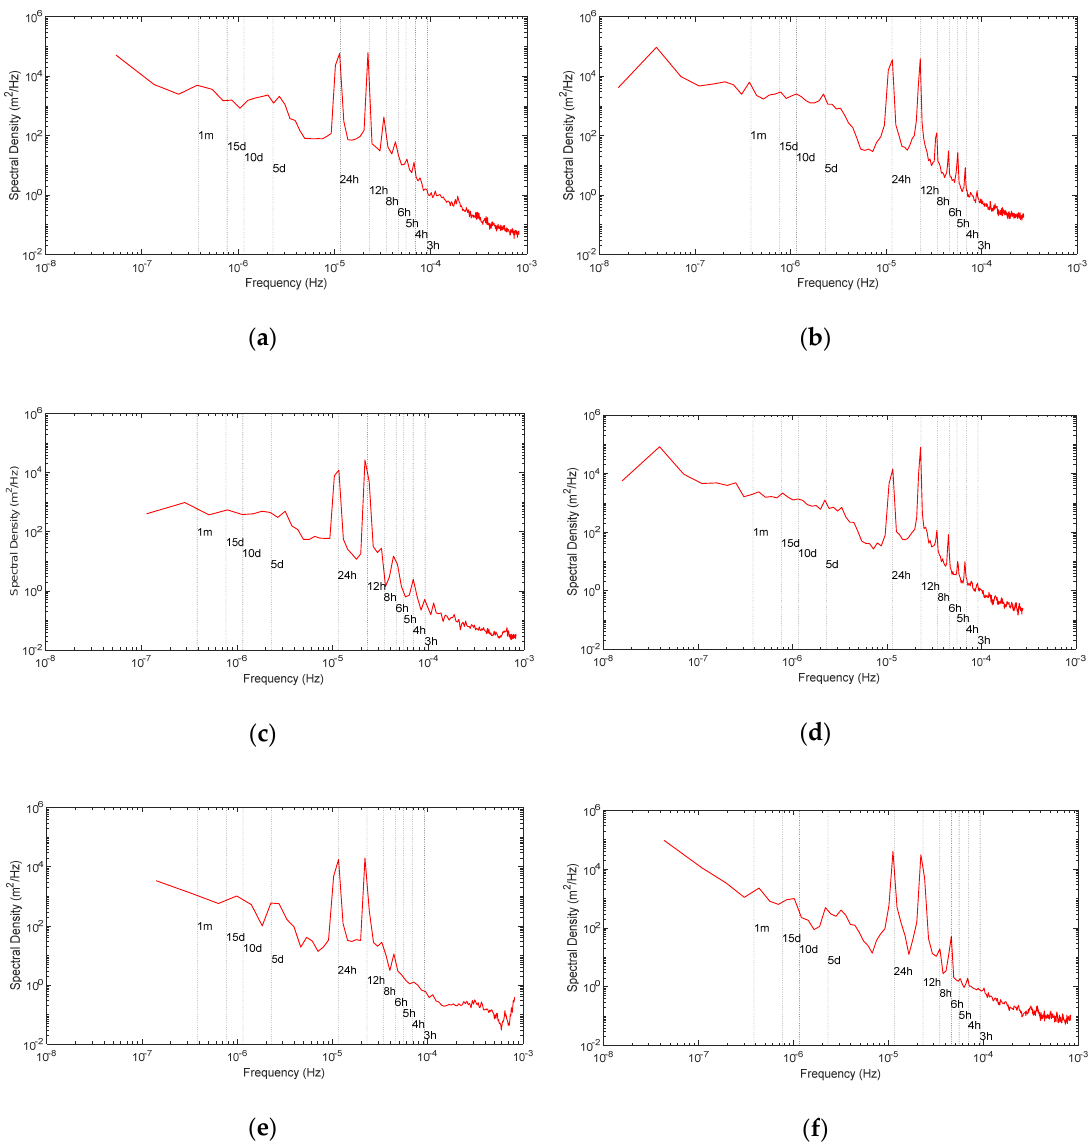
Figure 5. Energy spectrum of sea level at ( a ) Deylam station; ( b ) Bushehr station; ( c ) Lavar station; ( d ) Kangan station; ( e ) Javad al-Aemmeh station; ( f ) Bostaneh station.